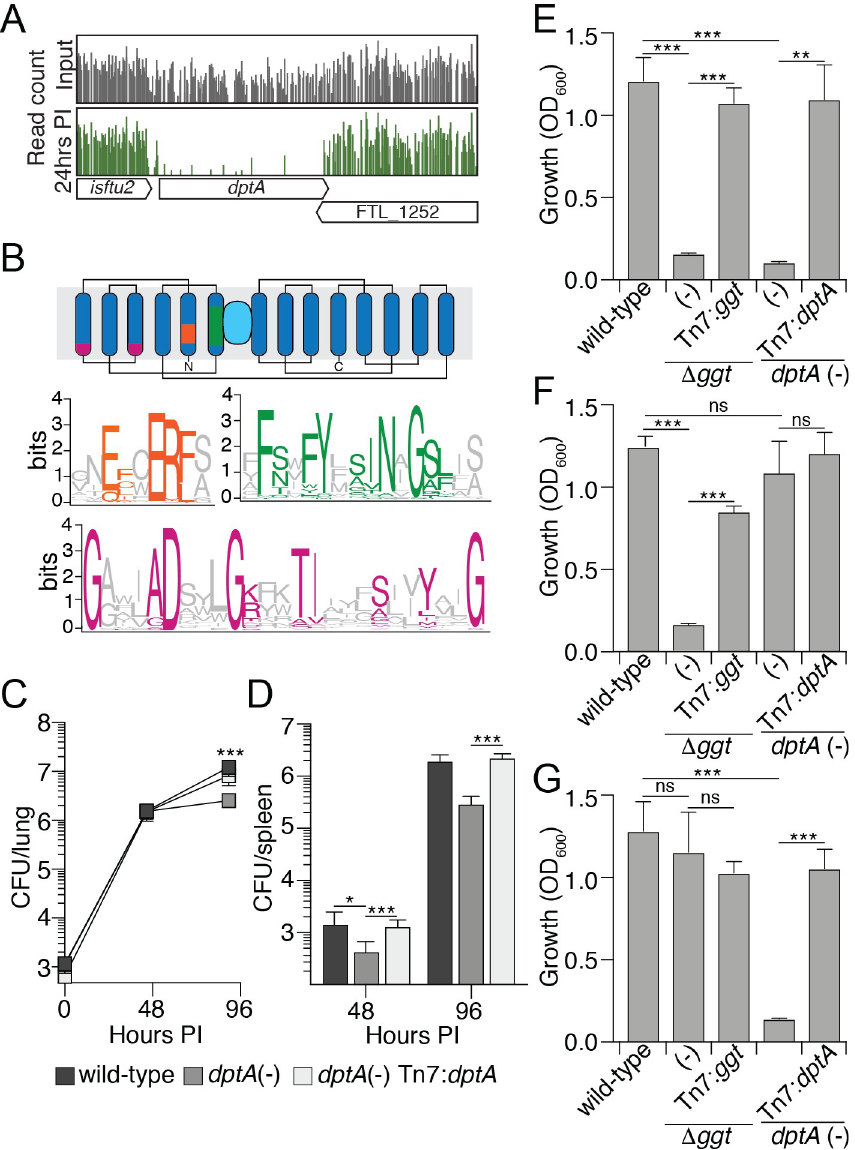
Fig 2. DptA is a POT that contributes to GSH utilization by LVS. (A) Transposon insertion profiles for the genetic region encompassing dptA from the input library (grey) and 24 hr post infection (green). Line height represents the relative abundance of sequencing reads at that position on a log scale. (B) Graphical representation of the predicted topology of DptA with conserved sequences motifs found in POT proteins highlighted (proton binding motif, orange; PTR2 domain 1, green; PTR2 domain 2, pink; peptide binding region, light blue). Sequence logo indicates motifs conserved in the POT family derived from an alignment of representative POT proteins. (C) Quantification of the bacterial burdens in the lungs of mice infected via aerosolization with the indicated strains of LVS. (D) Quantification of the bacterial dissemination to, and burdens within the spleens of mice infected via aerosolization with the indicated strains of LVS. (E-G) OD 600 measurements of the indicated strains of LVS after 16 hrs of growth in CDM with glutathione (E), γ Glu-Cys (F) or Cys-Gly (G). Data in (C-G) are shown as mean ± s.d. Asterisks represent statistically significant differences (Student’s t test; ��� p � 0.0005, �� p � 0.005, � p � 0.05, ns, not